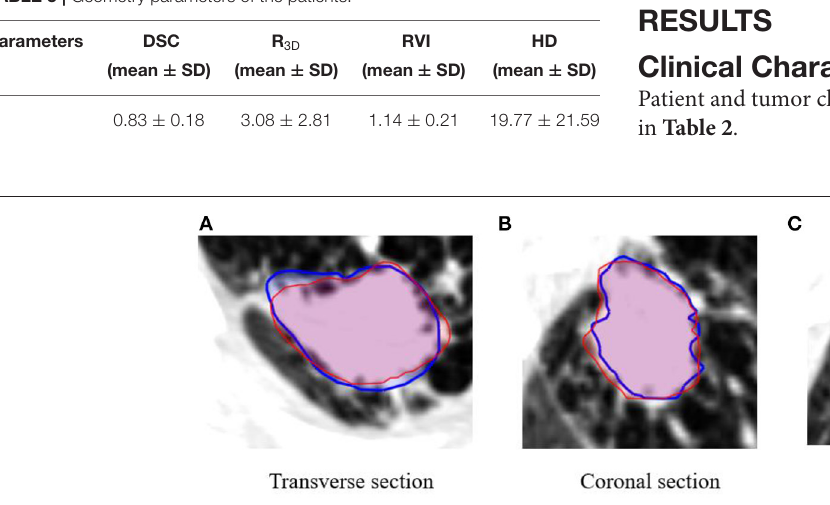
TABLE 3 | Geometry parameters of the patients.